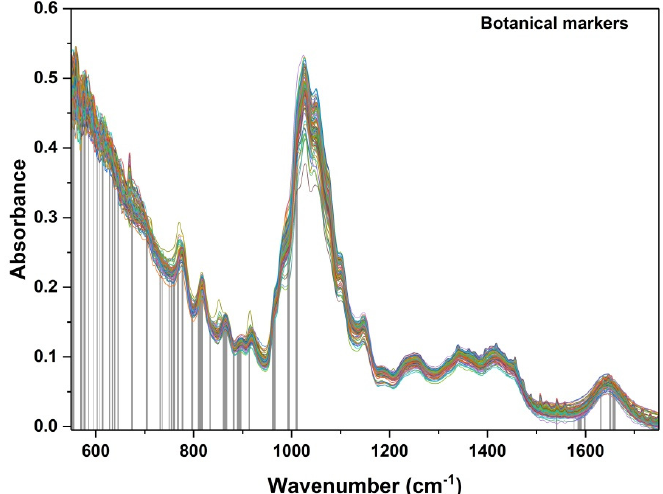
Figure 6. Plotted spectra of all investigated samples (for their differentiation distinct colors were used). The vertical lines marked the spectral points having high differentiation power for the botanical discrimination of the investigated honey samples.